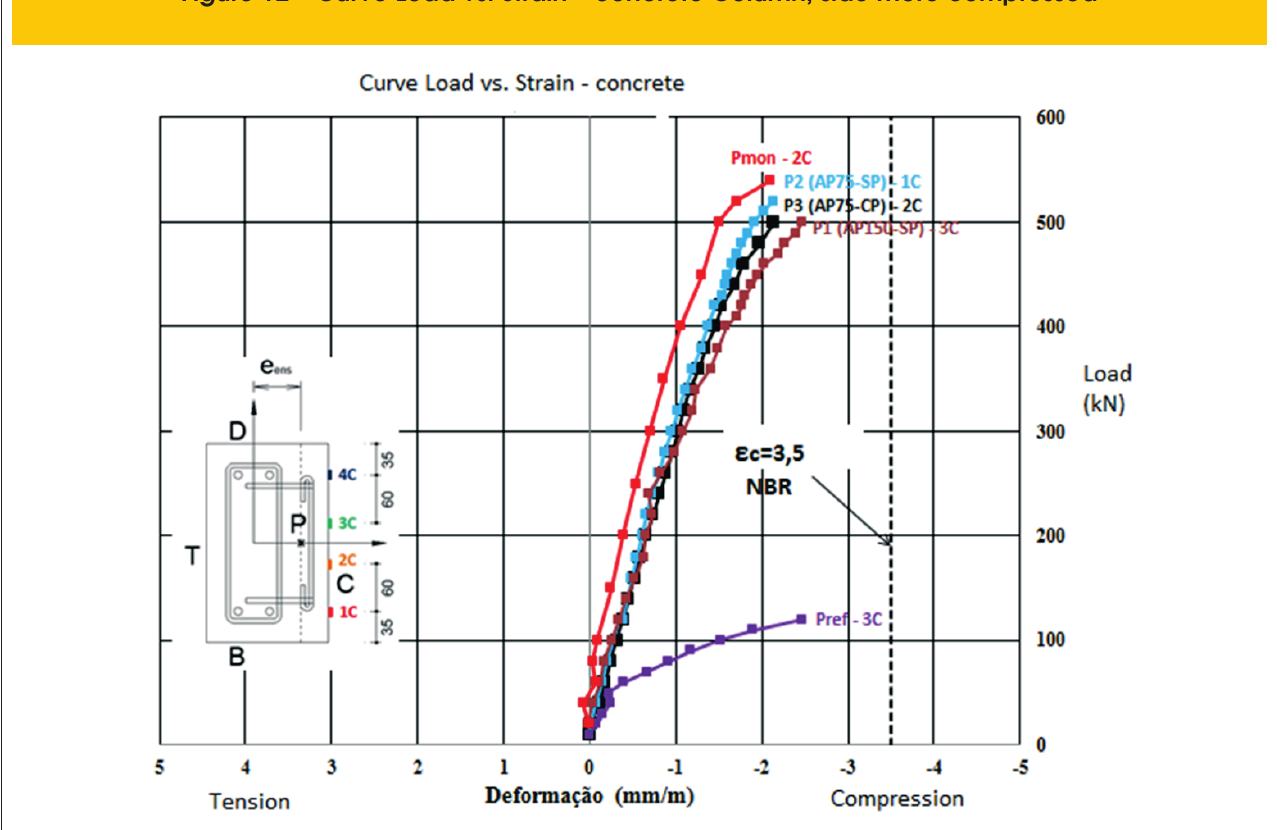
Figure 12 – Curve Load vs. Strain – concrete Column, side more